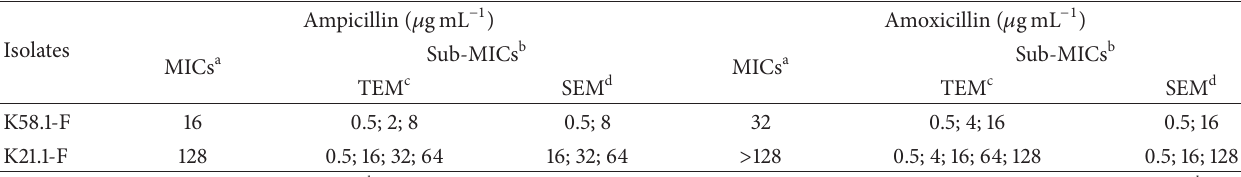
Table 2: MICs of K . pneumoniae isolates obtained of microbiota and sub-MICs used for analysis by electron microscopy. Ampicillin ( 𝜇 g mL −1 ) Amoxicillin ( 𝜇 gmL −1 ) Isolates Sub-MICs MICs a